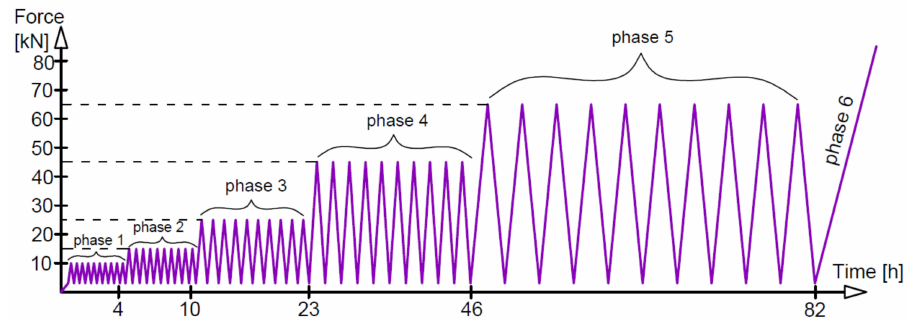
Figure 7. Loading and unloading.